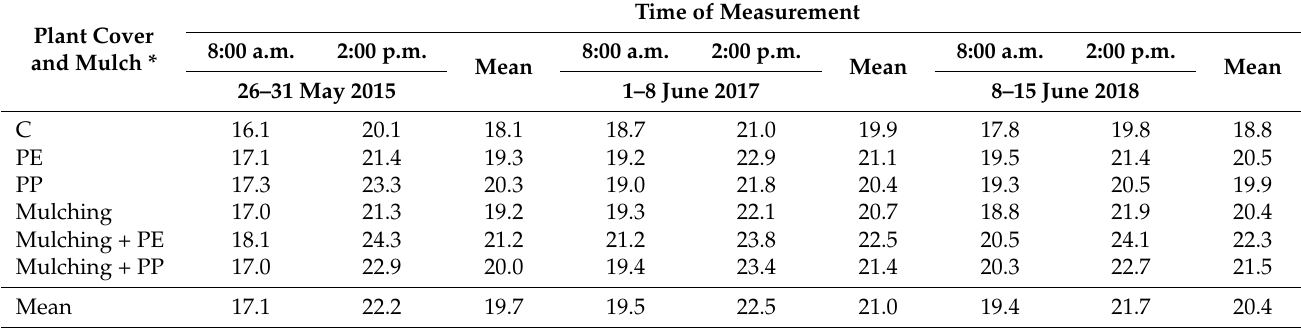
Table 8. The effects of plant covers and soil mulching on the average temperature of soil at a depth of 10 cm ( ◦ C). Plant Cover and Mulch *